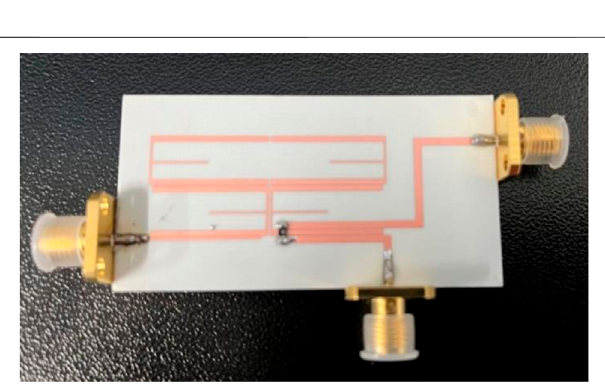
FIGURE 7 | Photograph of the fabricated circuit